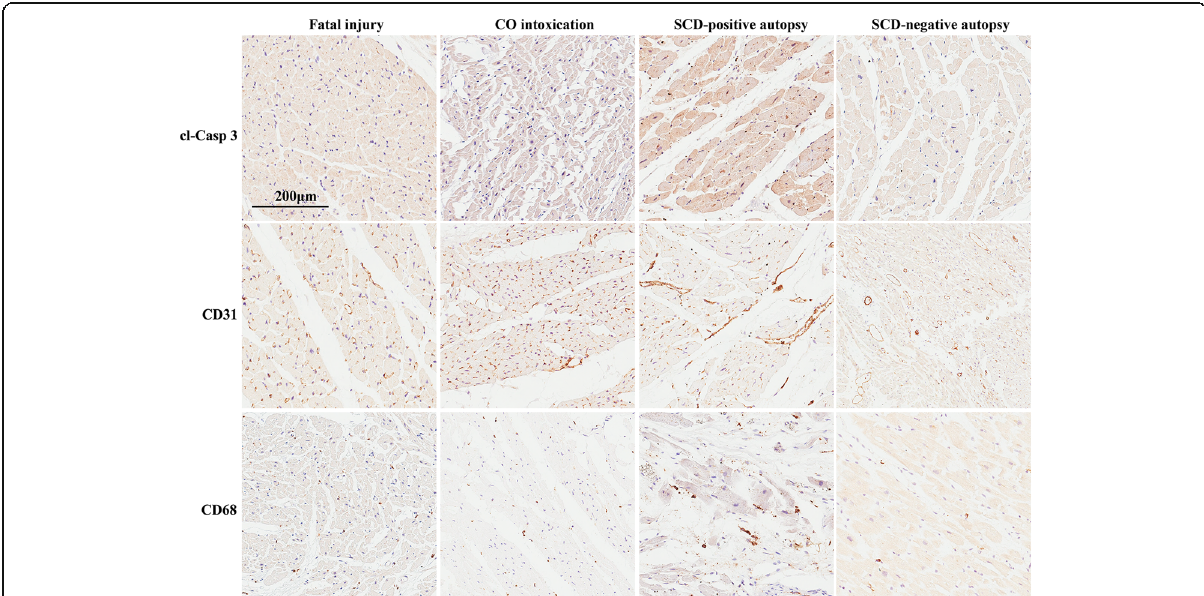
Fig. 2 Representative photographs of cleaved-Caspase3 (cl-Casp3), CD31, and CD68 expression in heart tissues stained by immunohistochemistry. SCD-positive autopsy group showed increases in the expression of cl-Casp3 (cytoplasm positivity in apoptotic cells), CD31 (lumen positivity), and CD68 (a marker of macrophage), whereas fatal injury and CO intoxication cases were absent from strong positivity of the above markers. SCD- negative autopsy cases showed patchy positivity of cl-Casp3 and dim CD31 signal, and were absent of CD68 positivity. Scale bar = 200 μ